Question: Describe this figure in one sentence.
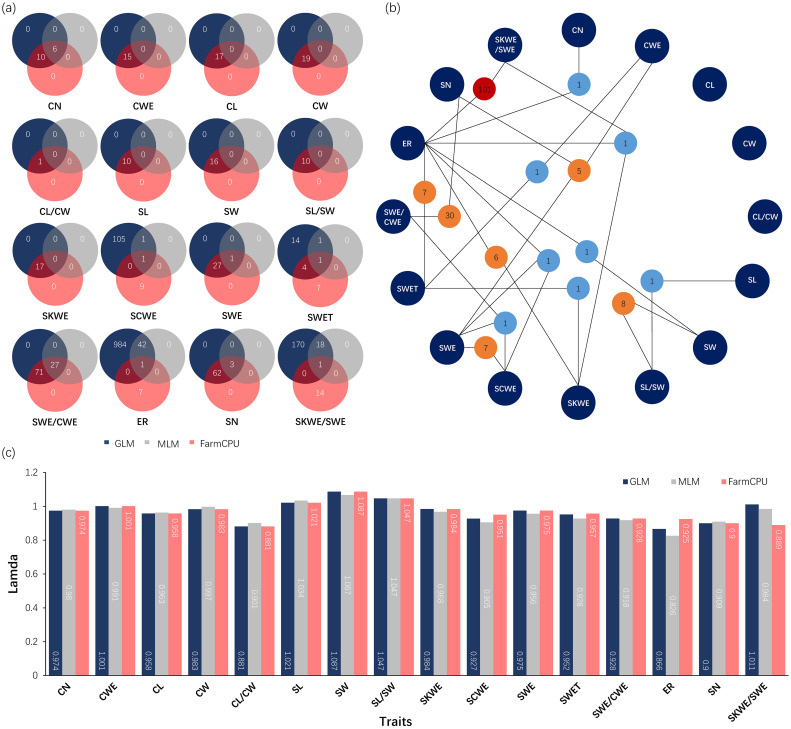
Answer: Results of GWAS. (a) Venn diagram of the number of SNPs associated with different algorithms for each trait. (b) Network diagram of the shared SNPs associated with each trait. (c) Lambda values corresponding to the various algorithms for each trait.